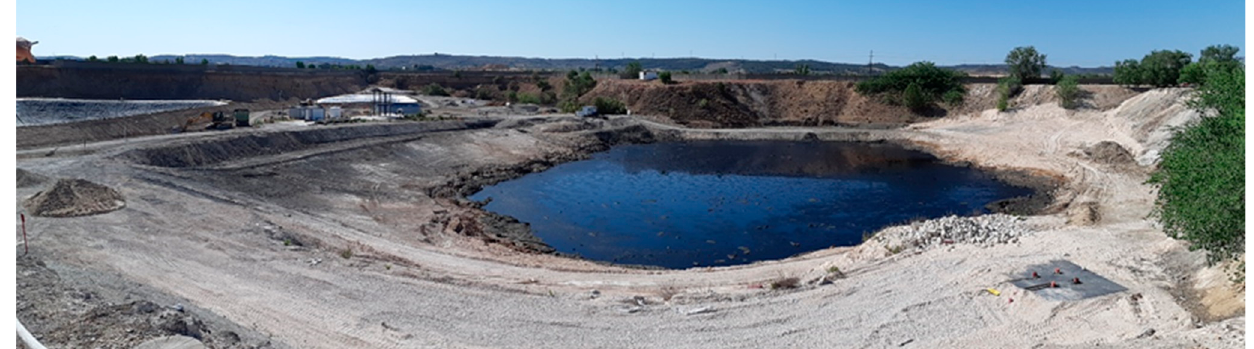
Figure 2. Arganda Lagoon and location of the cement plants considered in this study.